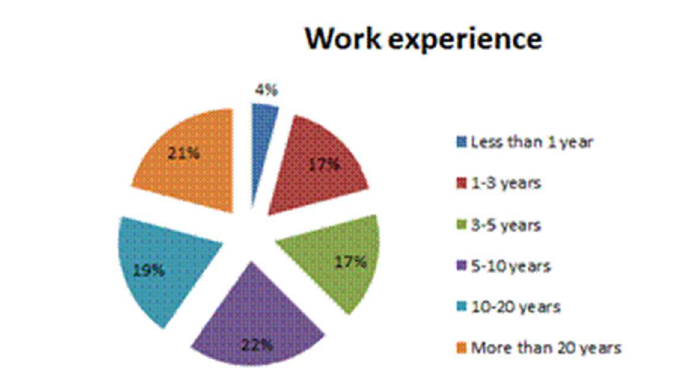
Figure 8 - Work experience in